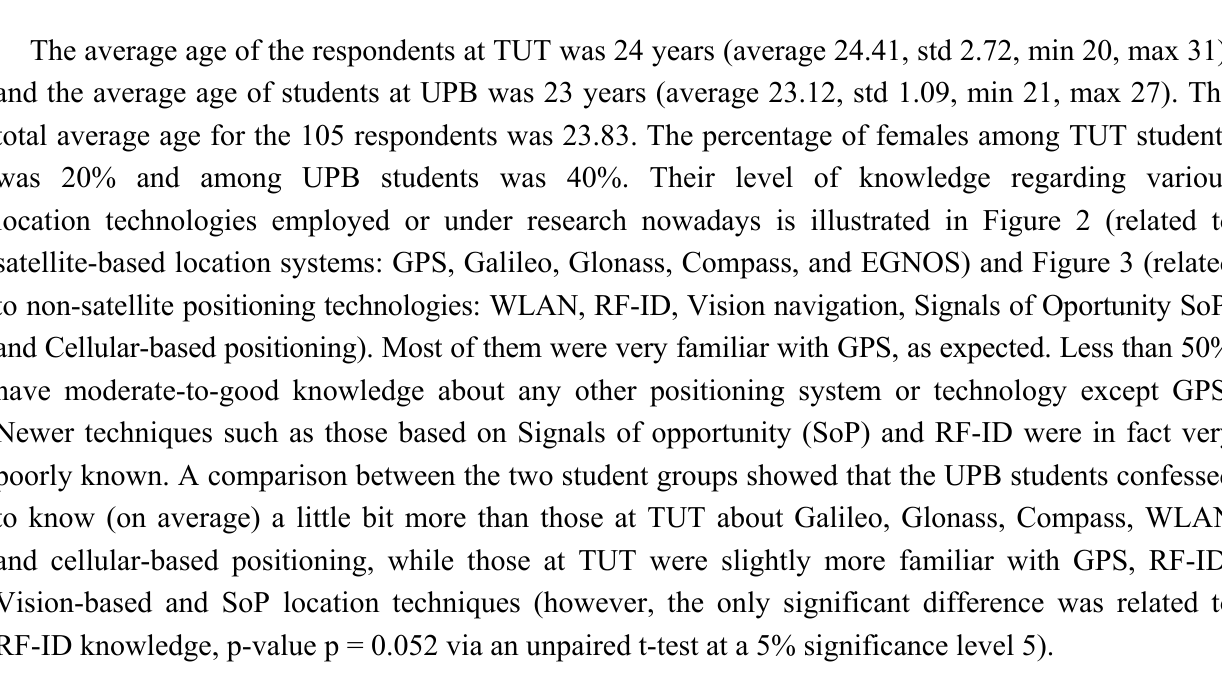
Figure 2. Familiarity level with satellite navigation systems.